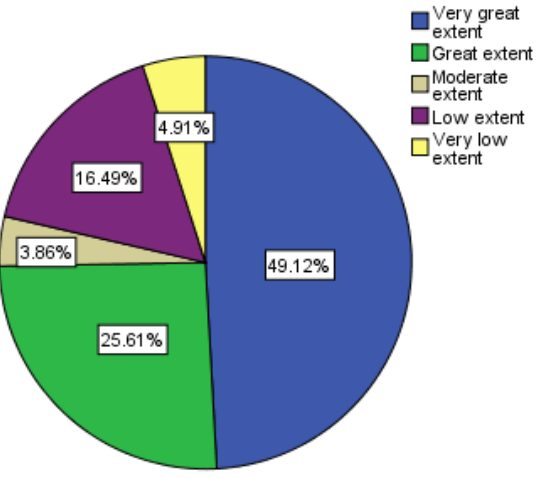
Figure 5. Pie chart showing the responses on customer satisfaction